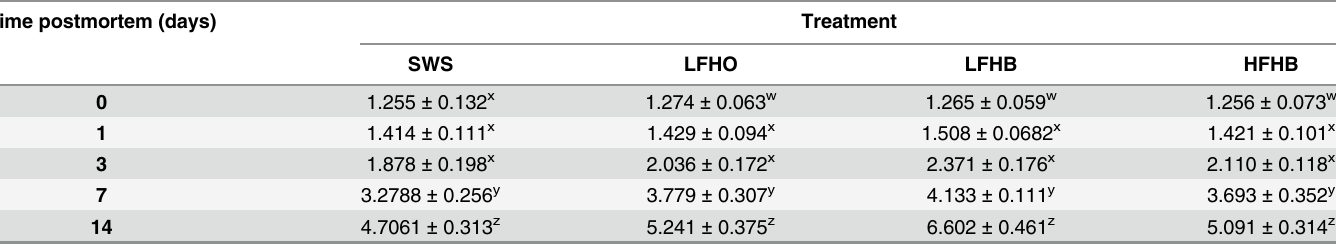
Table 2. Carbonyl content (nmol/mg protein) of longissimus lumborum muscle during postmortem aging periods in goats subjected to slaughter without stunning and slaughter following different methods of electrical stunning (mean ± SE, n = 8). Time postmortem